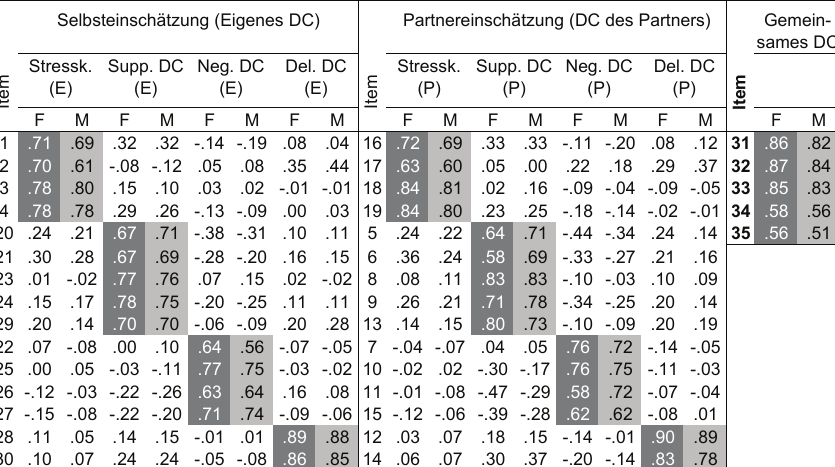
Tab. 5: Faktorielle Validität